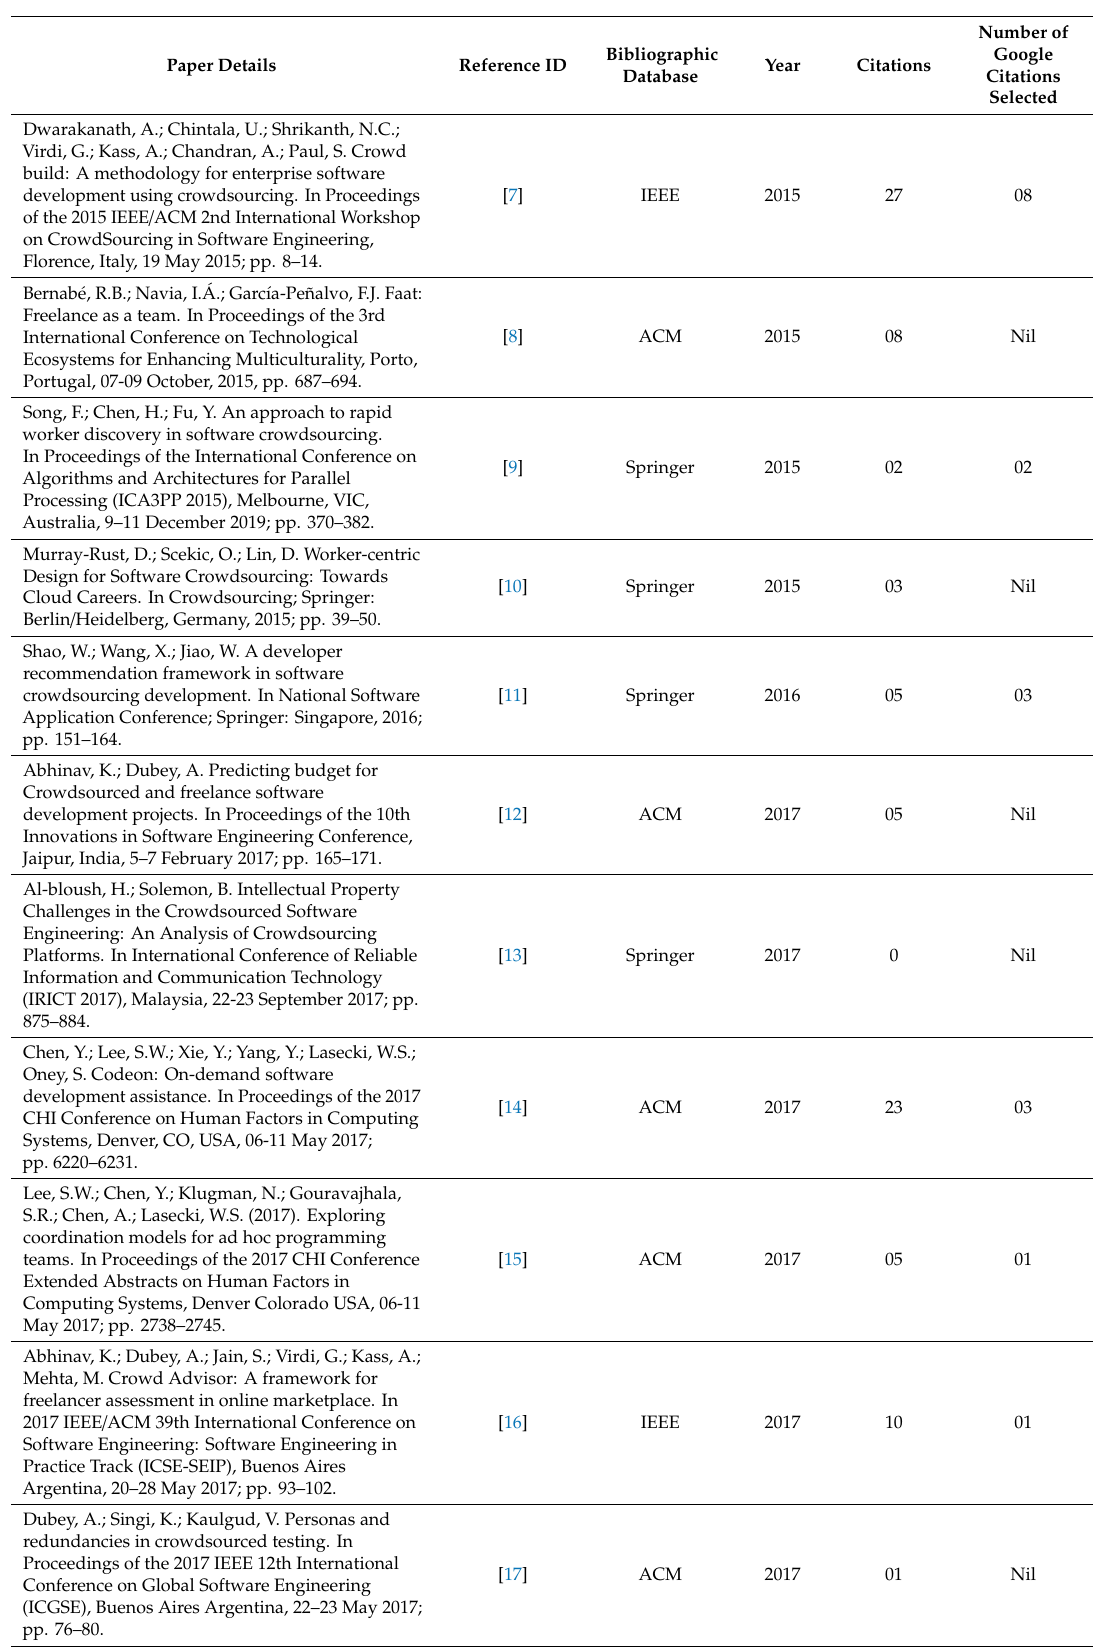
Table 2. Selected research